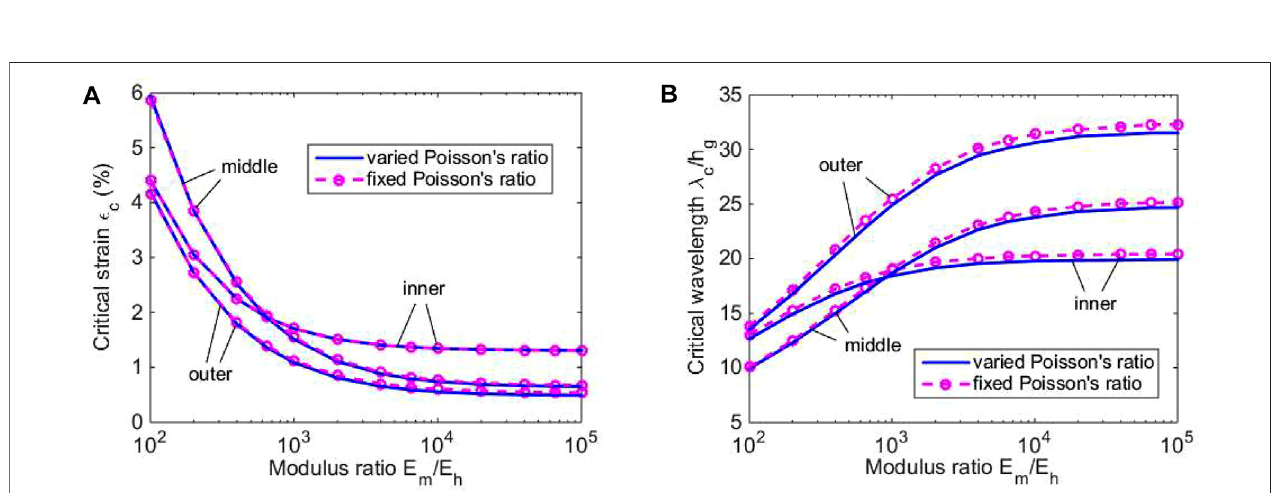
FIGURE 6 | Cross-sections of a homogeneous soft hollow cylinder containing a linearly graded stiff (A) inner layer, (B) middle layer, and (C) outer layer with the thickness h g .